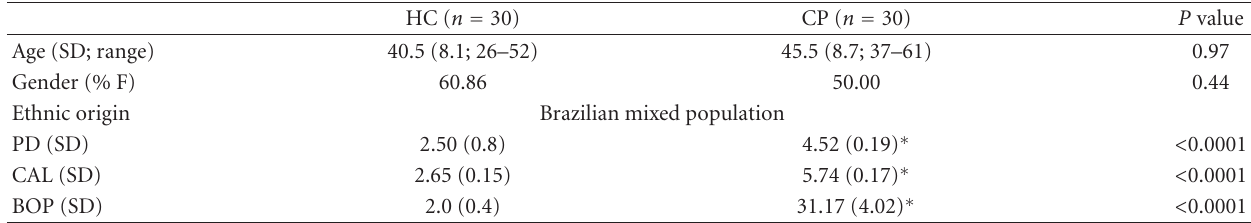
Table 2: Demographic and clinical features of the studied subjects.